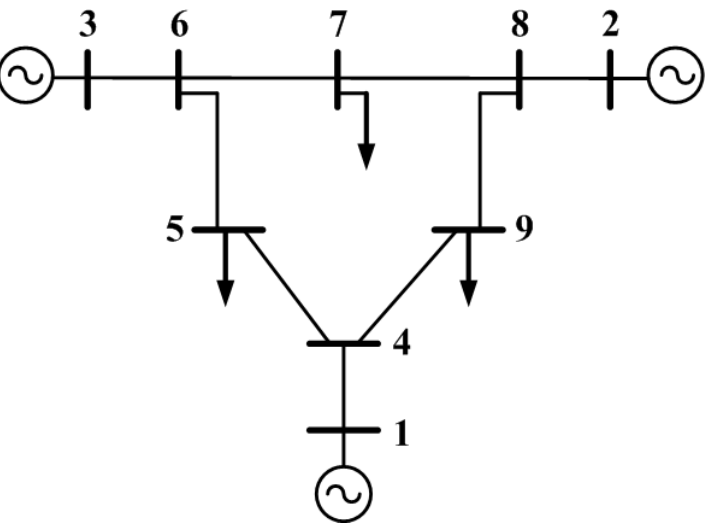
Figure 4. Nine buses